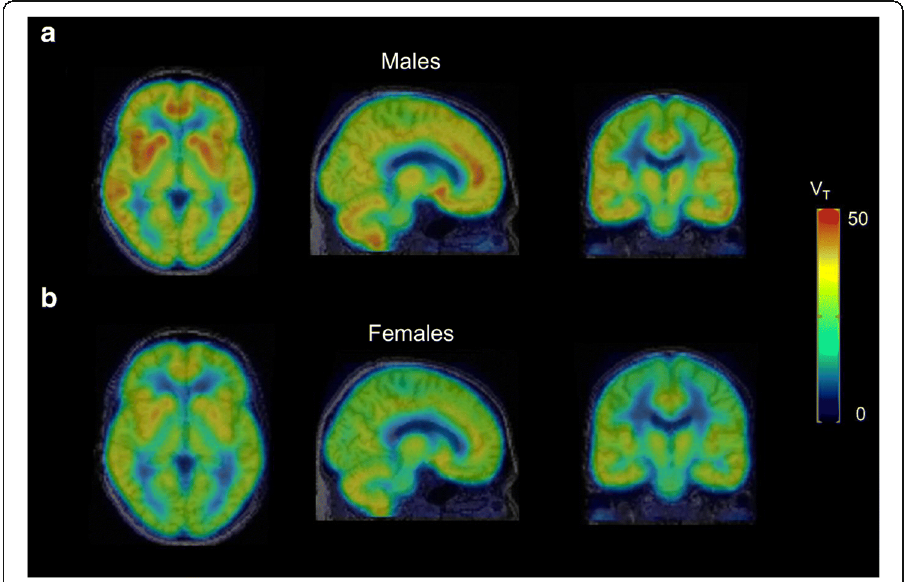
Fig. 8 Average parametric Logan graphical analysis (LGA) V T datasets for a 120-min [ 18 F]EKZ-001 PET scan ( n = 6 subjects per group, cohorts for radiotracer kinetic modeling, test-retest and inter-subject variability in brain, only the first scan was considered for subjects with 2 scans) for males a and females b . This